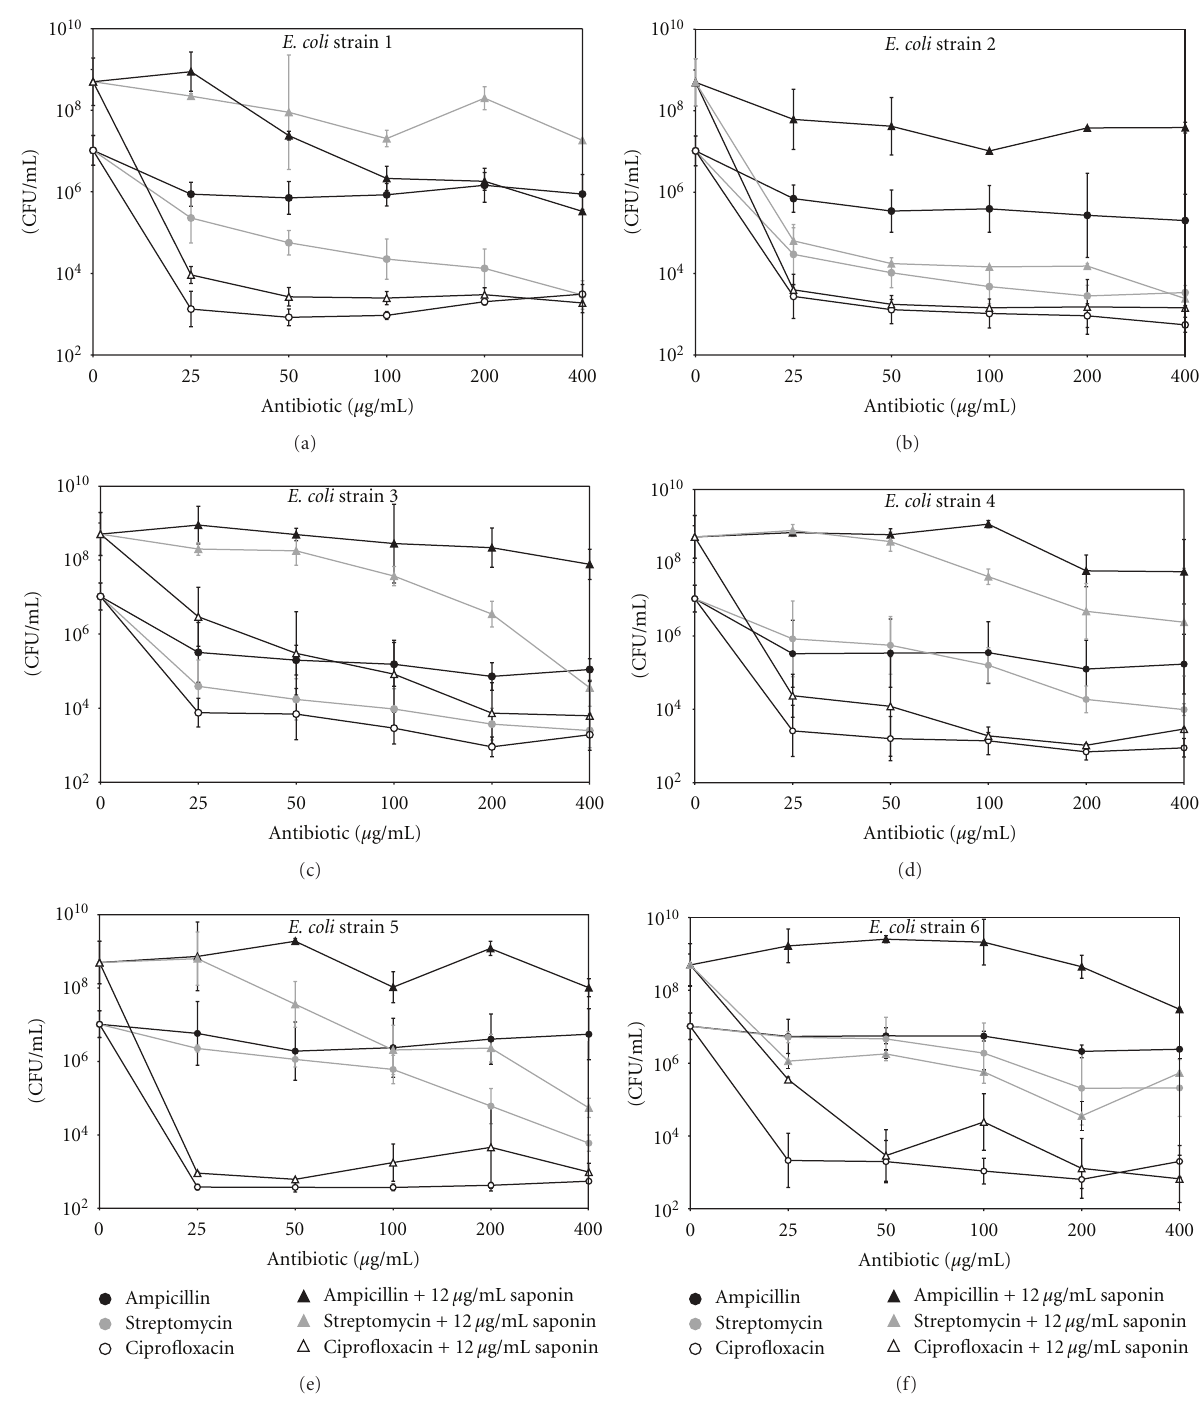
Figure 4: The e ff ect of saponin at 12 μ g/mL and ampicillin, streptomycin, or ciprofloxacin at concentrations ranging from 25 to 400 μ g/mL on the growth of the E. coli strains incubated for 18h at 37 ◦ C in LB medium; mean of three independent experiments ± SD.